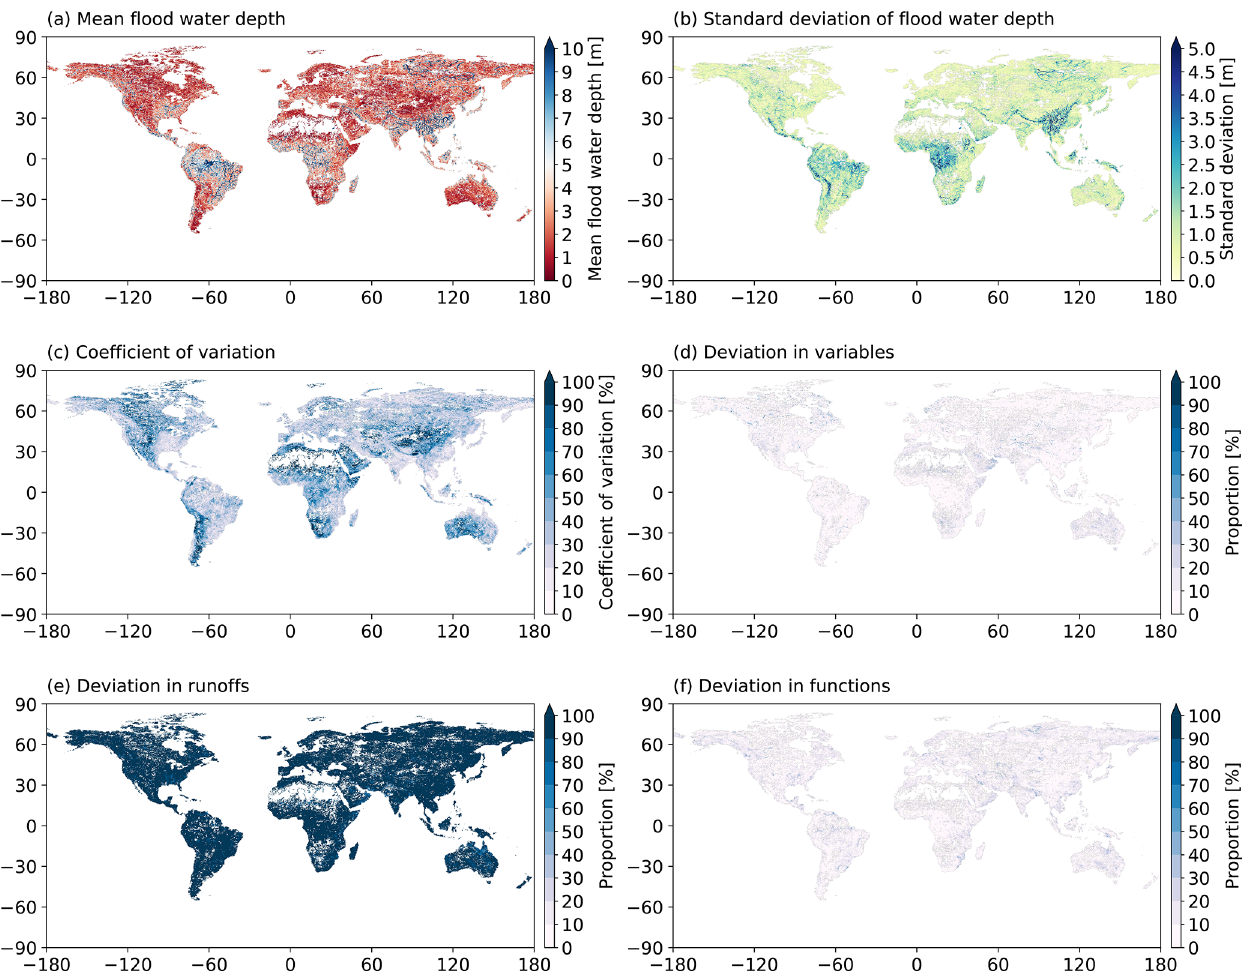
Figure 4. The mean and uncertainties of the flood water depth for the 1-in-100 year flood. The mean flood water depth (a) , the standard deviation (b) and the coefficient of variation (c) are estimated based on all of the experiments. The deviation proportion to the overall standard deviation (b) is displayed in (d–f) for different variables, runoffs and fitting functions,